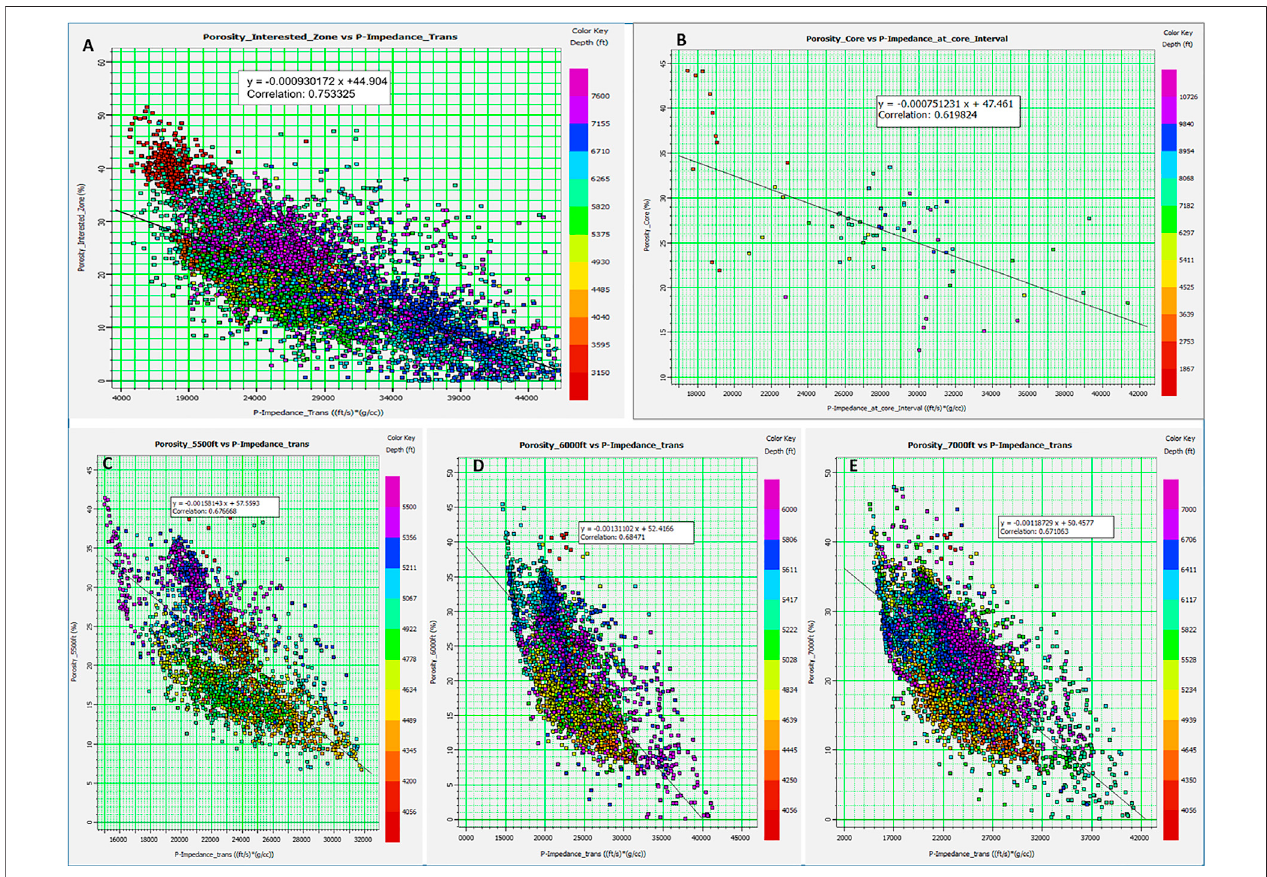
FIGURE 11 | (A) Acoustic impedance relationship with calculated porosity at an interested zone (3,150 – 7,600 ft) of the COST GE-1 well where the correlation coef fi cient is 0.75. (B) The acoustic impedance and measured porosity relationship for the entire well, where the correlation coef fi cient is 0.62. (C,D,E) Acoustic impedance versuscalculatedporositiesfromdensity and neutronlogsat threedifferentdepthintervalsat theTransco1005-1 well, wherethebestcorrelationcoef fi cient achieved is 0.6847 at the interval between 4,046 and 6,000 ft.